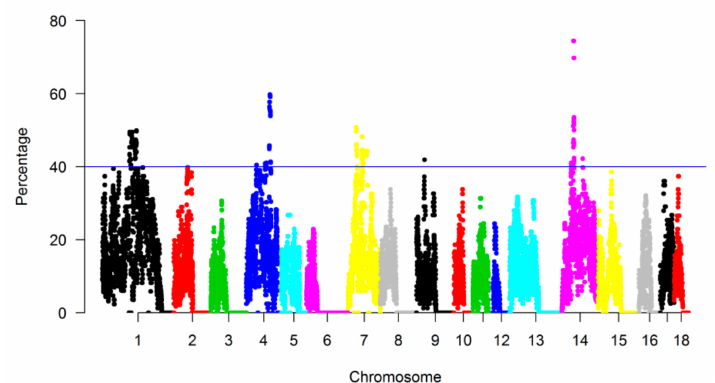
Figure 5. Manhattan plot of the occurrence (%) of single nucleotide polymorphisms (SNPs) in ROH across individuals. A colorful dot stand for a